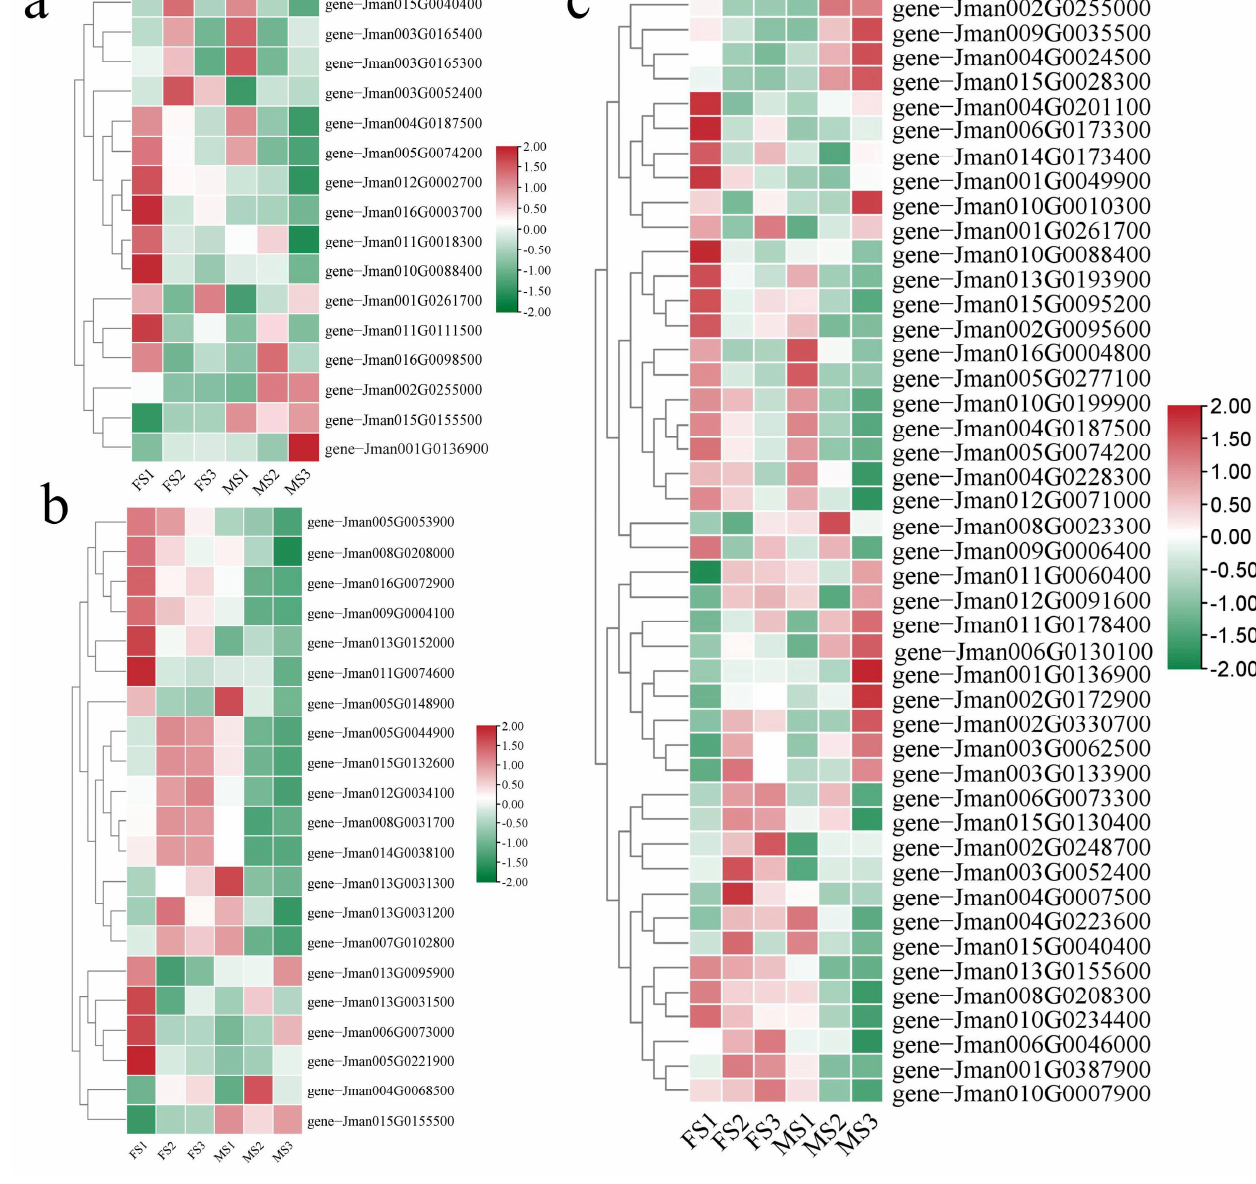
Figure 6. Identification of floral transition and flowering-related genes. ( a ) DEGs involved in photoperiod pathway; ( b ) DEGs involved in floral organ transition pathway; ( c ) DEGs involved in flower development pathway. The color scale from green to red indicates the expression value from low to high.